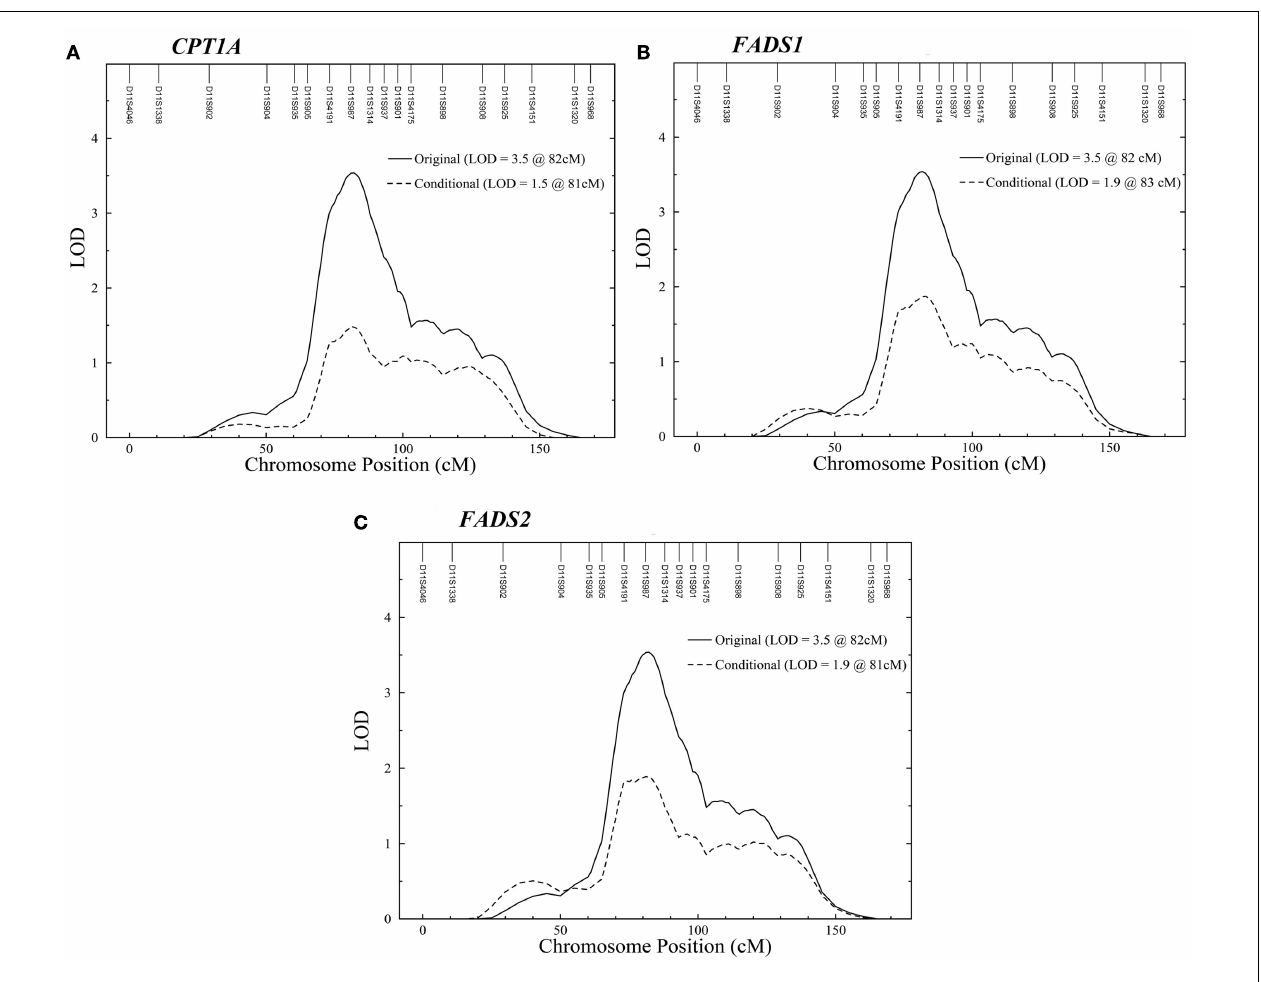
FIGURE 4 | Conditional linkage analysis for erythrocyte D5D on chromosome 11. Linkage analysis conditional on the most significantly